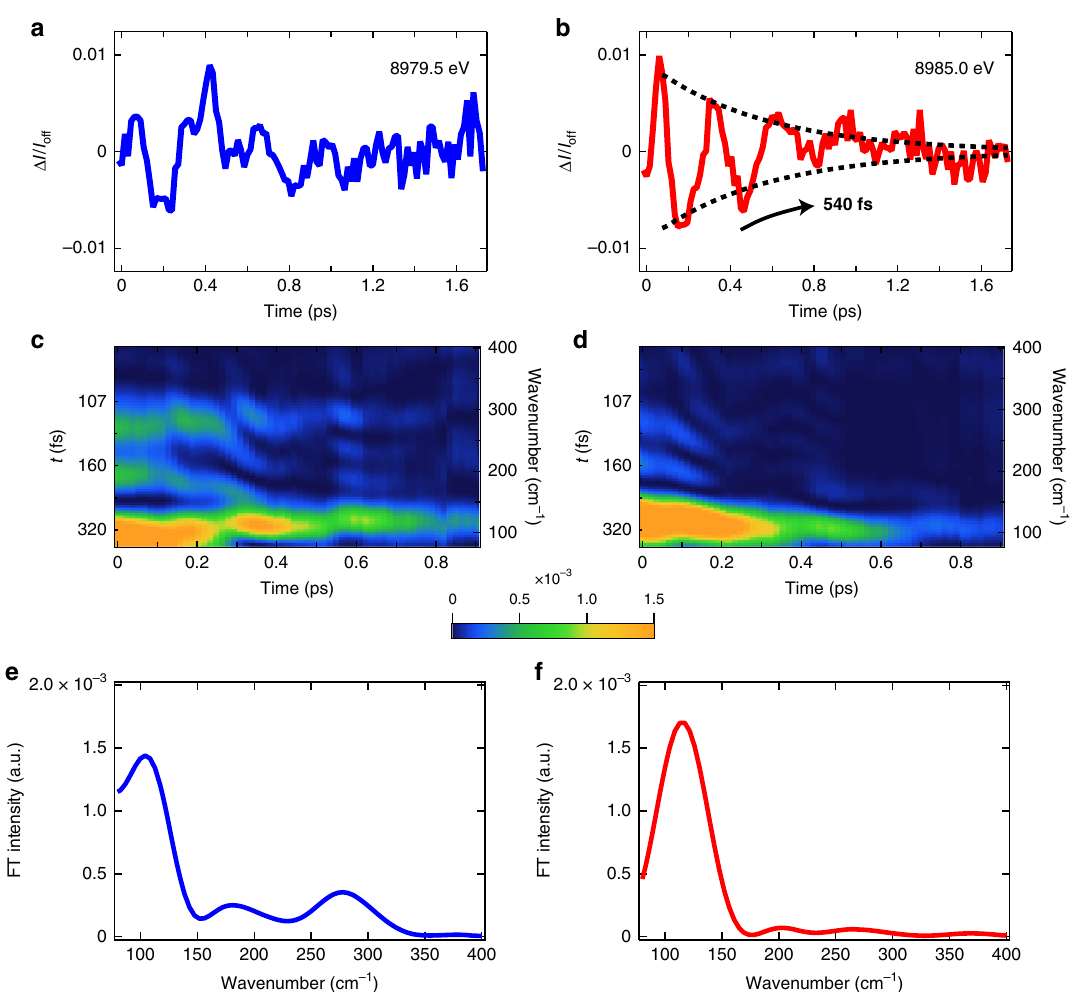
Fig. 3 Extracted coherent nuclear wavepacket. a , b The residual pro fi les after the global fi tting analysis at a 8979.5 eV, and b 8985.0 eV. At b 8985.0 eV, the oscillation decays with the time constant of 540 fs. c , d The time-dependent Fourier transform of a , b obtained by sliding 1 ps Hann window. The bottom axis is the central time of this Hann window. e , f The vertical projection of c , d with a time window of 0 – 0.4